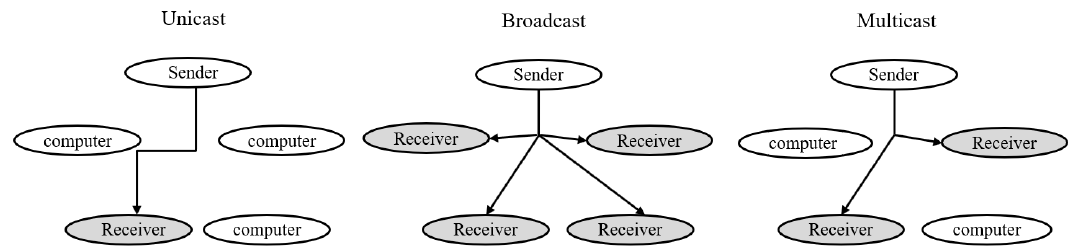
Figure 1. The unicast, broadcast, and multicast solutions (modified from reference [17] ).